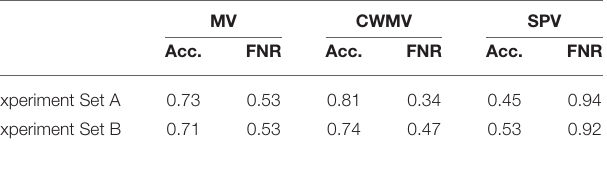
TABLE 2 | Performance analysis of voting methods for balanced dataset.